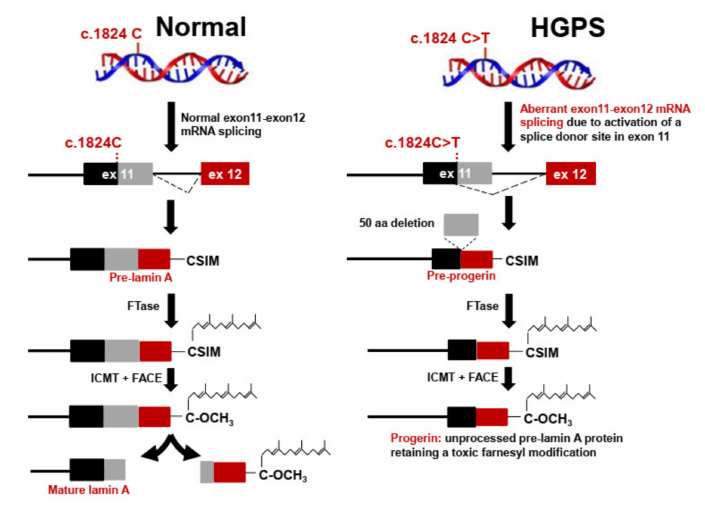
Figure 1. Defective post-translational processing of prelamin A in Hutchinson-Gilford progeria syndrome (HGPS). Newly synthesized prelamin A is farnesylated by farnesyltransferase (FTase) on the C-terminal CSIM motif. The CSIM motif is then cleaved by the Ras-converting CAAX endopepti- dase 1 (RCE, also called FACE-2) or the zinc metalloprotease Ste24 (Zmpste24, also called FACE-1), and the resulting C-terminal Cys residue is methylated by the isoprenylcysteine carboxylmethyl transferase (ICMT). Finally, the 15 residues from the C-terminus, including the farnesylated and carboxymethylated C-terminal Cys, are cleaved by the endoprotease Zmpste24/FACE-1. In most HGPS patients, the mutation GGC to GGT in LMNA codon 608 (G608G) activates a cryptic splice site that causes the deletion of a 50-amino acid sequence containing the Zmpste24 cleavage site, thus preventing cleavage of the 15 C-terminal amino acid residues and resulting in the accumulation of the mutant form of farnesylated prelamin A called